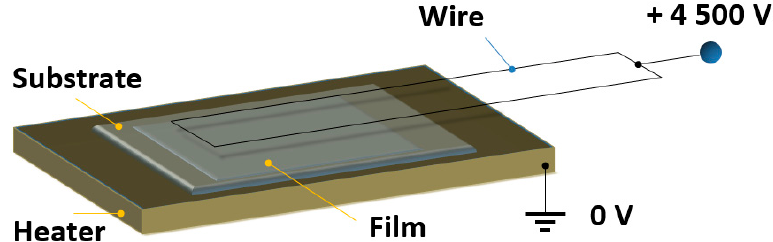
Figure 3. Corona-poling setup. The substrate is a BK7 glass slide. The distance between the wire and the film is approximately 1